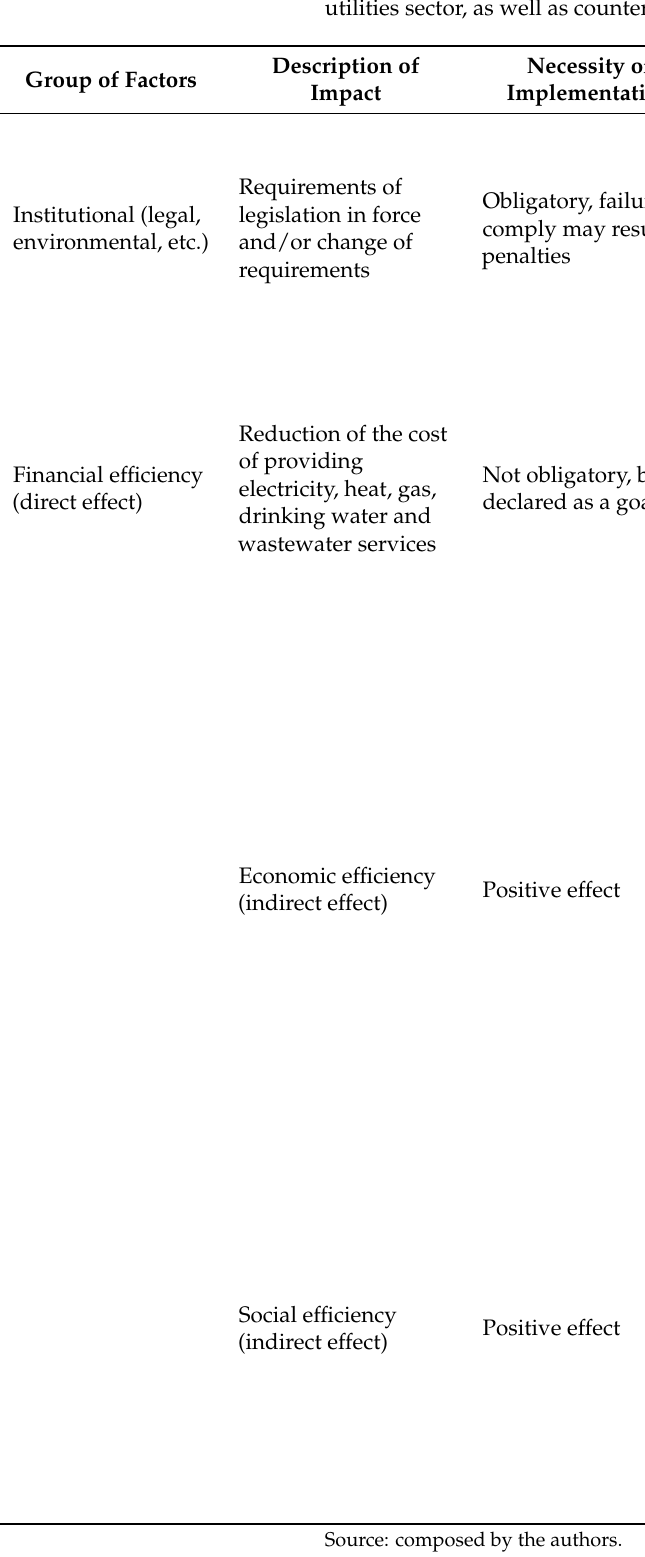
Table 6. A roadmap of the measures for introducing energy-saving technologies in the housing and utilities sector, as well as